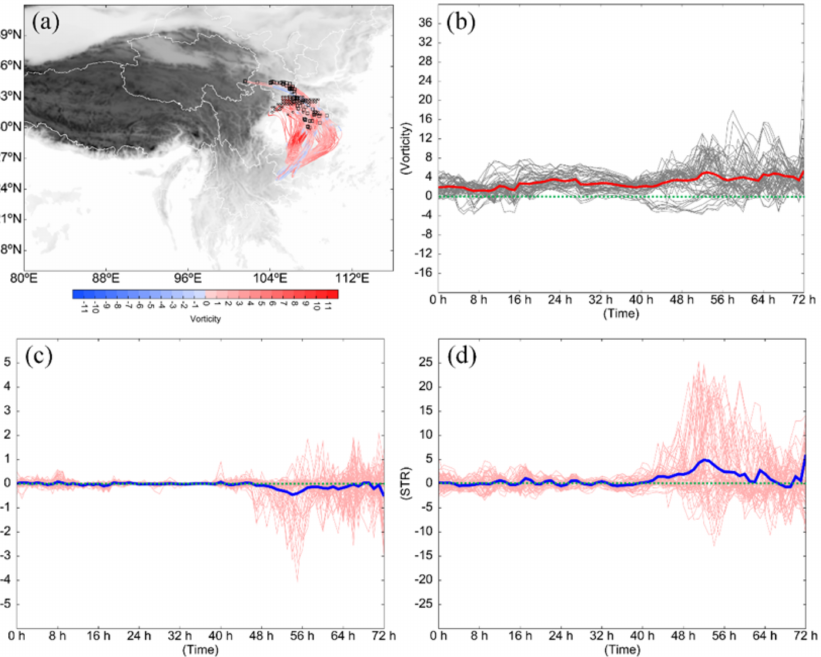
Figure 8. The same as Figure 5, but for the POS-LAB type trajectories. Panel ( a ) shows the backward (from 1800 UTC 26 to 1800 UTC 23 June 2020) trajectories and vorticity (shading, units: 10 − 5 s − 1 ) of the air particles that belong to the POS-LAB type, where black boxes/circles show the initial/final locations of the air particles. Panel ( b ) shows the vorticity variations of the POS-LAB-type trajectories (units: 10 − 6 s − 1 ). Panels ( c , d ) show the budget terms TIL and STR of the POS-LAB-type trajectories, respectively (units: 10 − 10 s − 2 ).